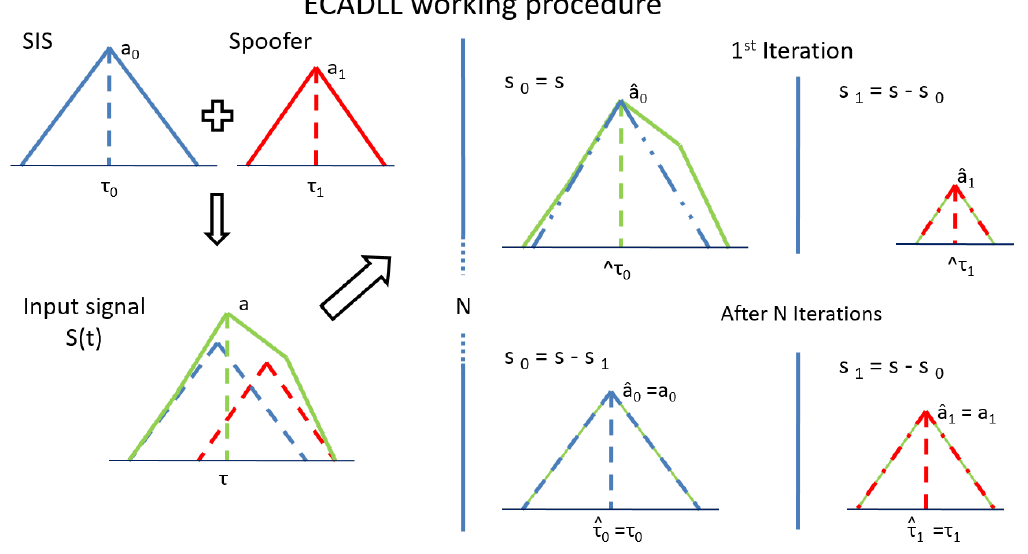
Figure 2. ECADLL basic working procedure when the satellite signal and the spoofing signal are aligned in phase. On the left, the incoming signal is shown, and on the right, the solution after N iterations. Only the in-phase channel is shown in this image for